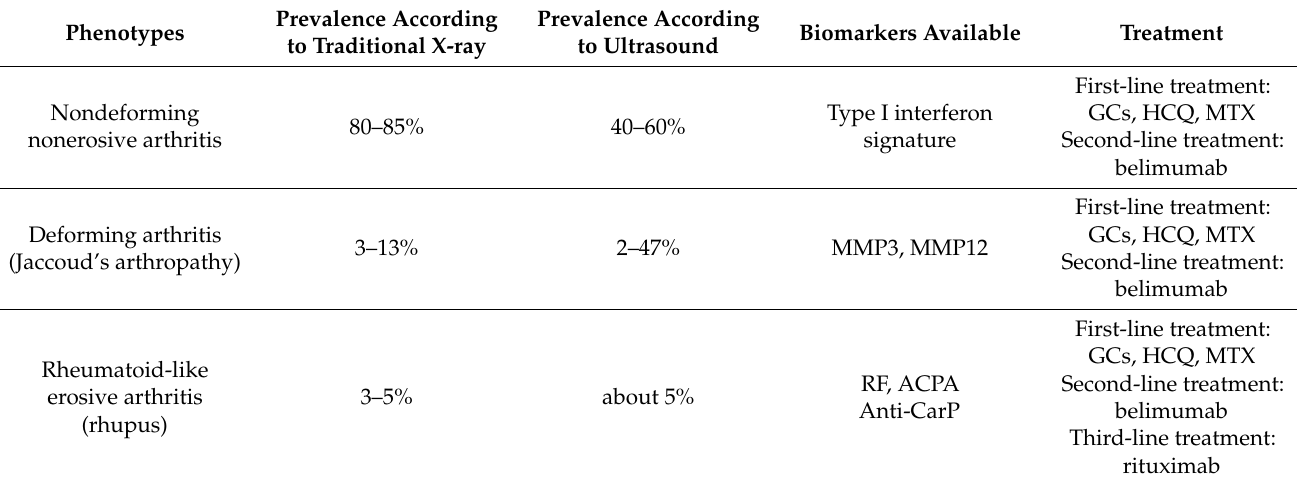
Table 1. Lupus-related